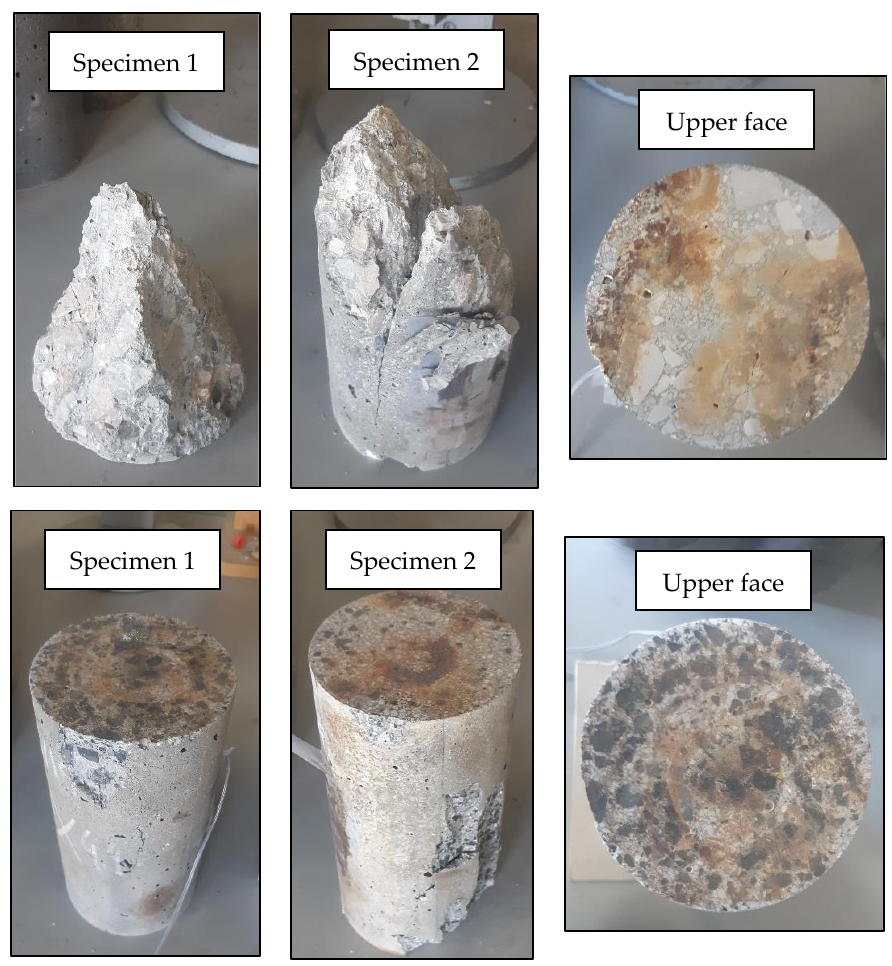
Figure 11. Post-test appearance of LLC ( top ) and SLC ( bottom ) mix specimens after